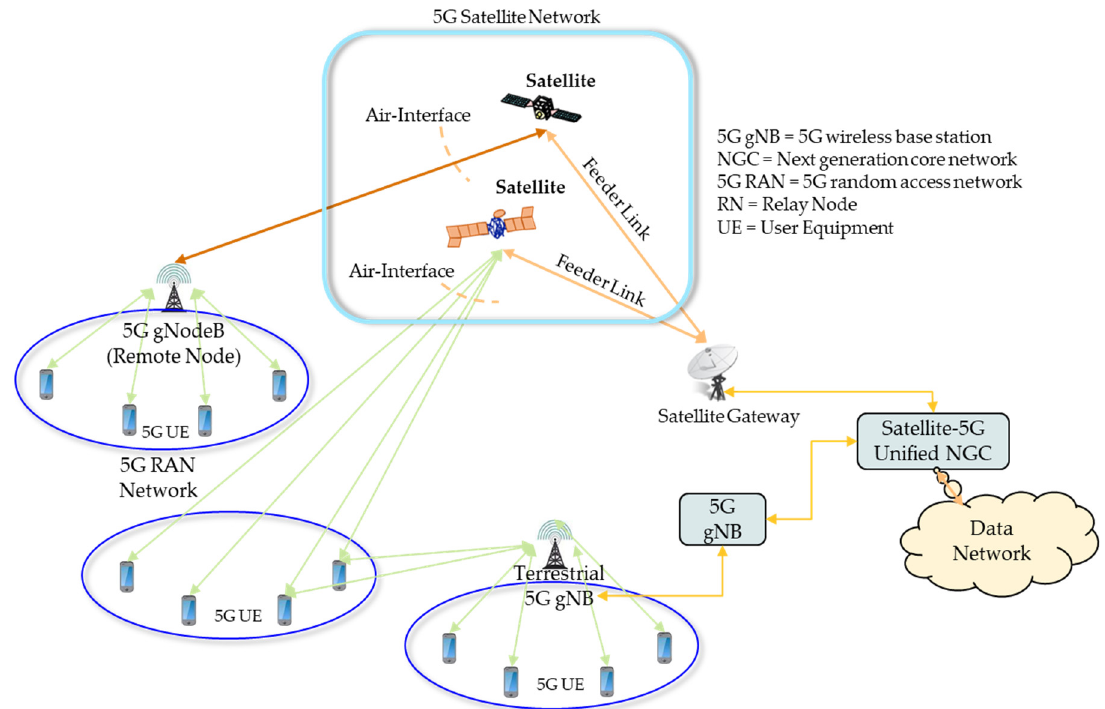
Figure 7. Strawman SATis5 Architecture for Mid-Term Solution.